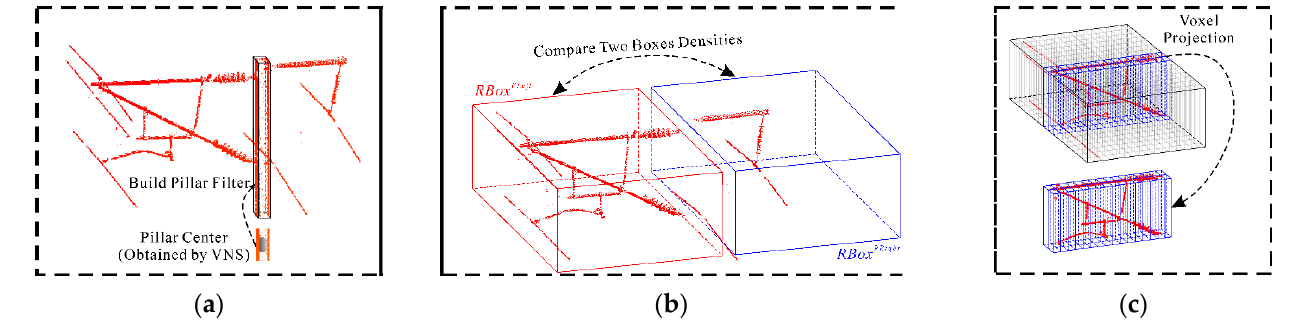
Figure 5. Flowchart of the result optimization. ( a ) Pillar filter. ( b ) Rough crop. ( c ) Voxel projection filter.